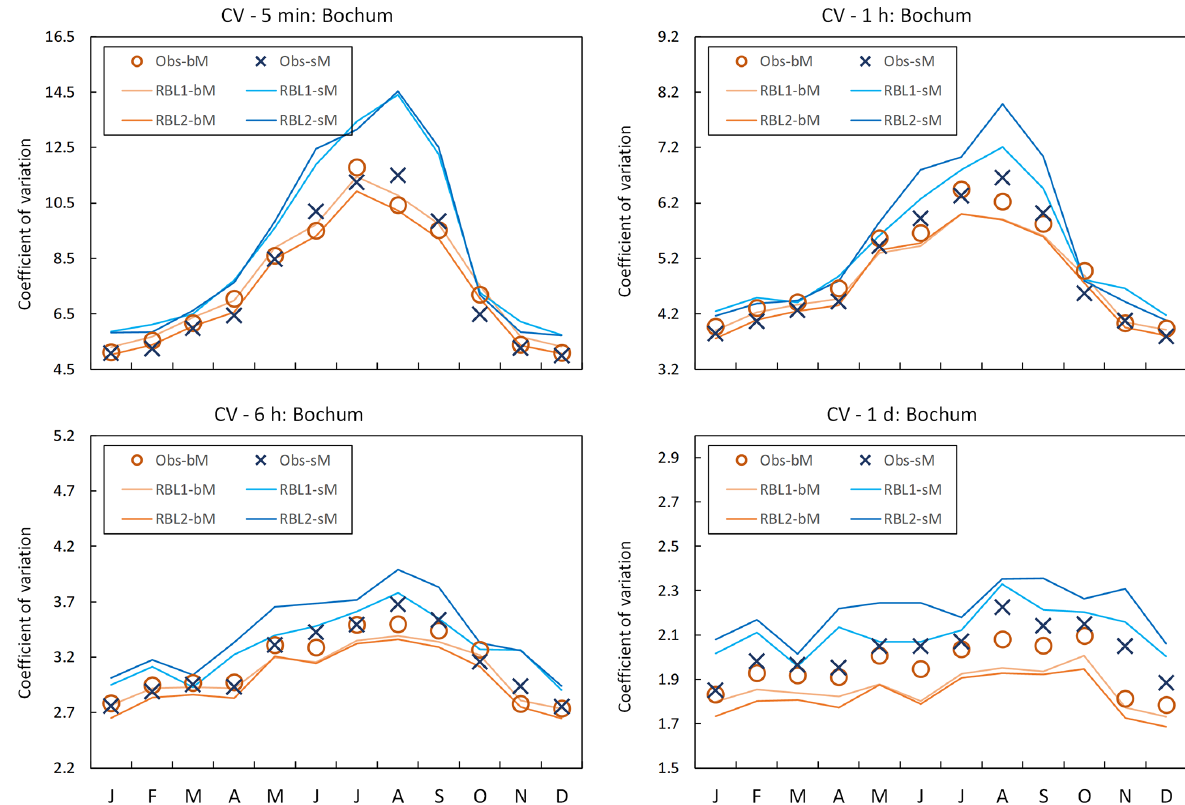
Figure 4. Coefficient of variation (CV) by month at Bochum: the observed calculated CV with block (Obs-bM, orange circle markers) vs. standard (Obs-sM, blue cross markers) methods, CV fitted with the RBL1 (RBL1-bM, light orange line; RBL1-sM, light blue line) models, and CV fitted with the RBL2 (RBL2-bM, orange lines; RBL2-sM, blue lines) models.